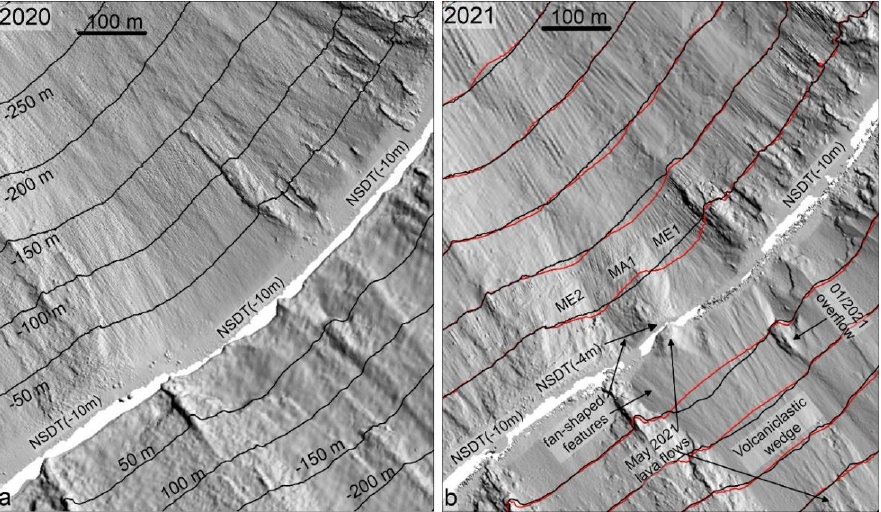
Figure 6. ( a ) The 2020 shaded relief map and contours (equidistance 50 m) of the central part of the SdF, where a main depression is recognizable, partially filled by small ridges and fan-shaped features; NSDT: nearshore submarine depositional terrace and related average depth of the outer edge. ( b ) The 2021 shaded relief map and contours (equidistance as in ( a )); black and red contour lines refer to the 2020 and 2021 DEMs, respectively. MA1 and ME1 – 2 as in Figure 5.